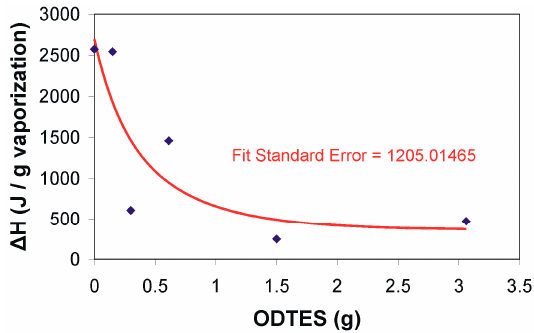
Figure 3. Variation in the vaporization enthalpy of the water dispersions as a function of the ODTES amount used for silica hydrophobization (The line is for guiding the reader. The experimental data were plotted, and the given curve was fitted with Table Curve 2D version v5.01 software. The fit standard error calculated by the software is written inside the chart).